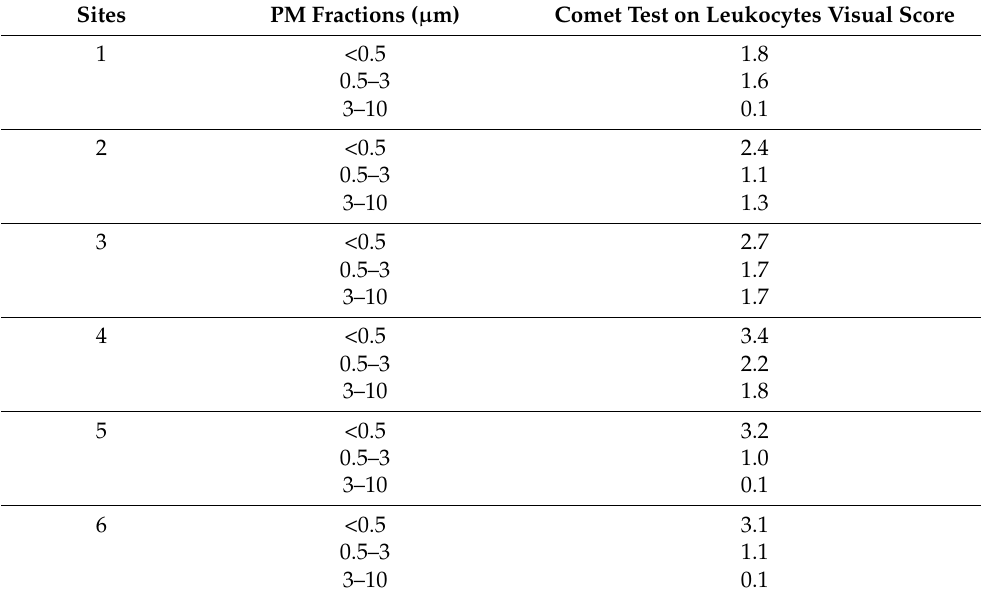
Table 1. Results of an in vitro comet test on leukocytes expressed as an increase of DNA damage per each m 3 of air according to the sites and PM fractions. Sites PM Fractions ( µ